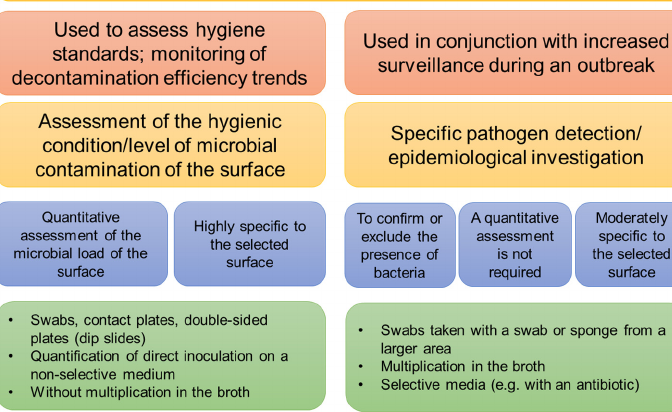
Figure 5. Microbiological monitoring of the hospital environment.